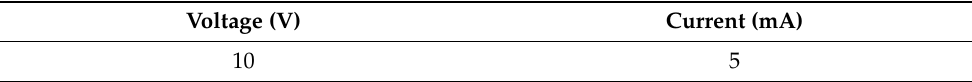
Table 3. The parameters of battery–piezoelectric fiber